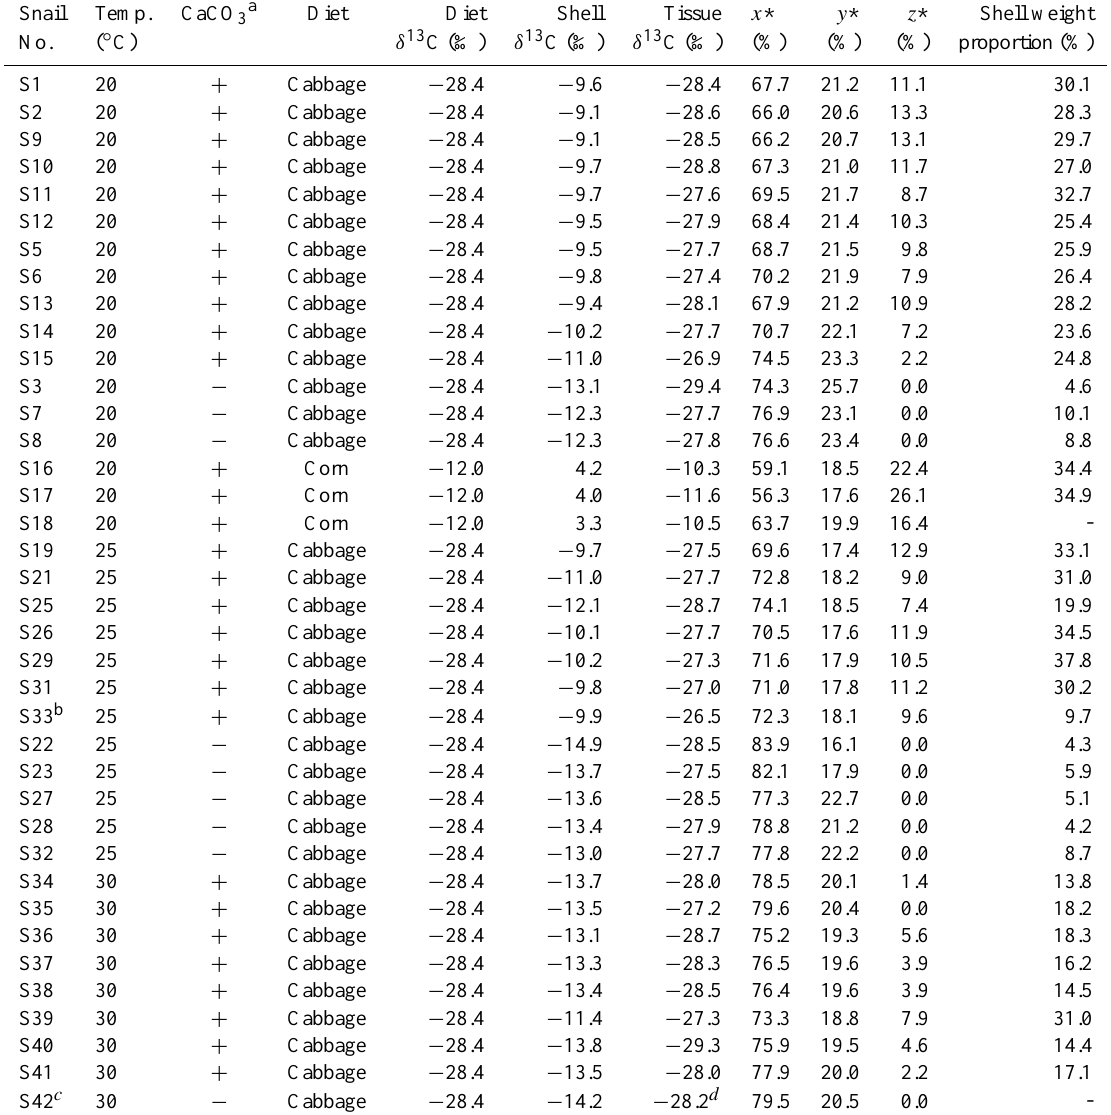
Table 1. Stable isotope results of snails cultured under different conditions and the estimated contributions of their shell carbon sources. Snail Temp. CaCO 3a Diet Diet Shell Tissue x * y * z * Shell weight No. ( ◦ C) δ 13 C (‰) δ 13 C (‰)